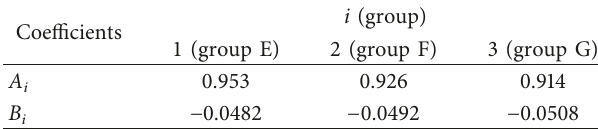
∼ N curves under coupling of hot-wet R i and B i for group E